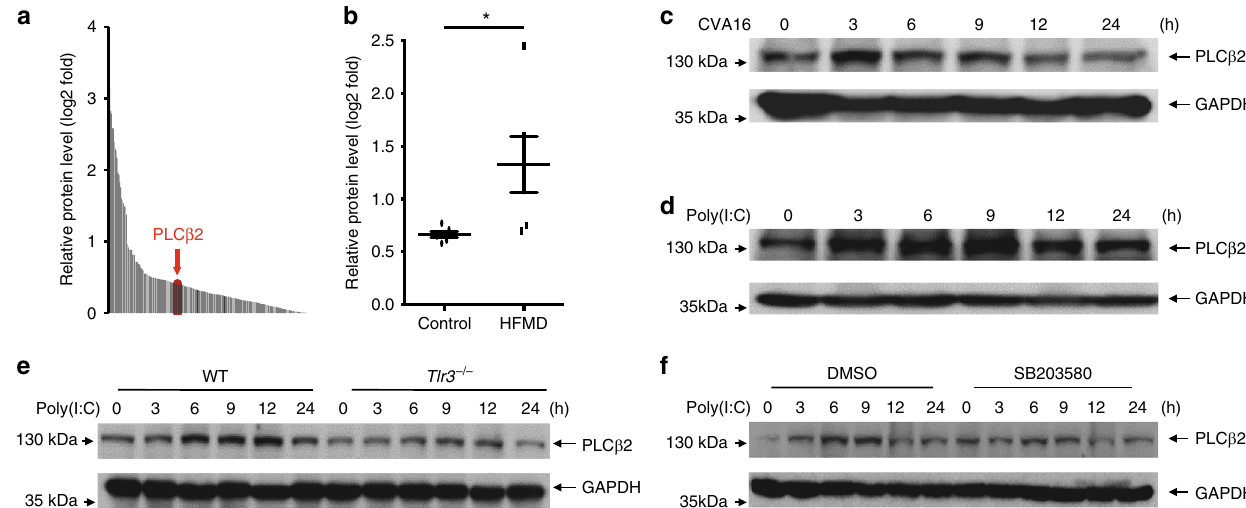
Fig. 1 RNA virus infection speci fi cally induces PLC β 2 expression. a Protein expression ratio of white blood cells mixture from control and HFMD group patients detected by mass spectrometry. b Immunoblot (IB) and analysis of PLC β 2 in PBMC from control and HFMD patients. c , d IB of PLC β 2 in lysates of mouse peritoneal macrophages infected with CVA16 virus ( c ) or stimulated with poly(I:C) ( d ) for the indicated times. e IB of PLC β 2 in wild-type or Tlr3 − / − mouse peritoneal macrophages stimulated with poly(I:C) for the indicated times. f IB of PLC β 2 in mouse peritoneal macrophages pretreated for 1 h with the p38 inhibitor SB203580 before poly(I:C) stimulation for the indicated times. * p < 0.05 by unpaired t -test ( b ). Data are representative of three experiments with at least three independent biological replicates (mean and s.e.m. of n = 6 per group in b and n = 3 cultures in c – f